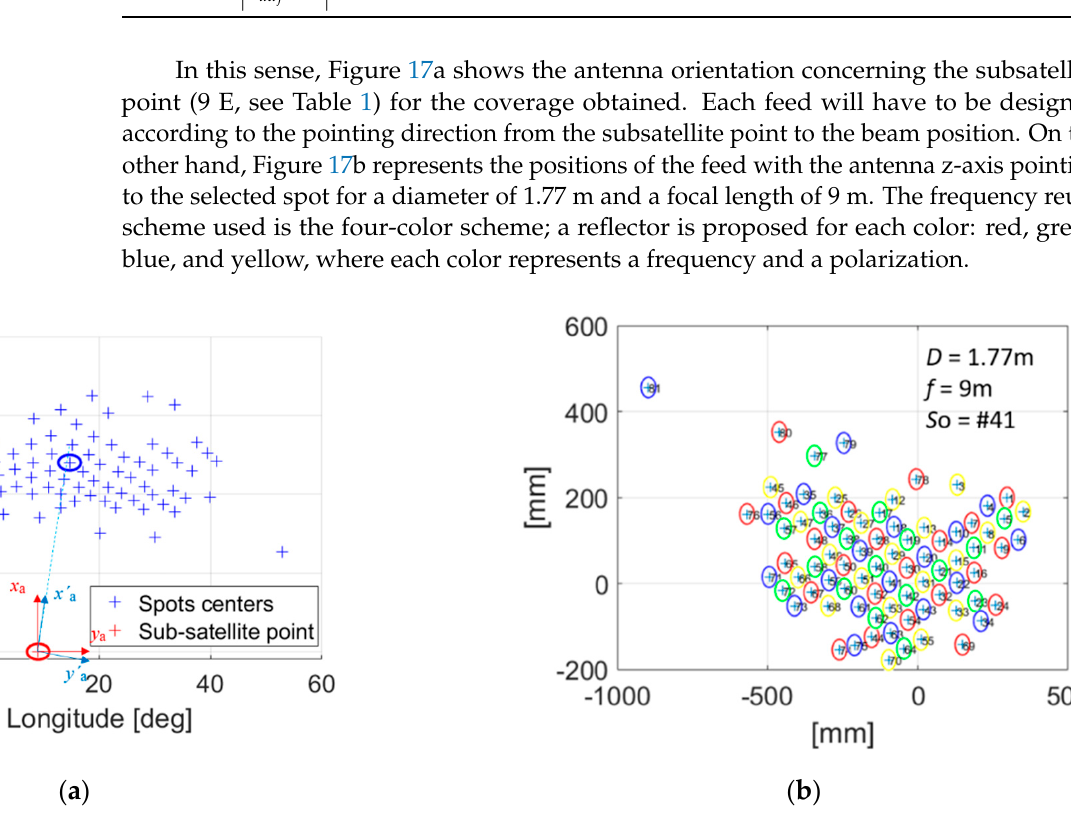
Figure 17. ( a ) Position of the spots centers and z-axis direction; ( b ) Feeds positions with the antenna z-axis pointing to selected spot.